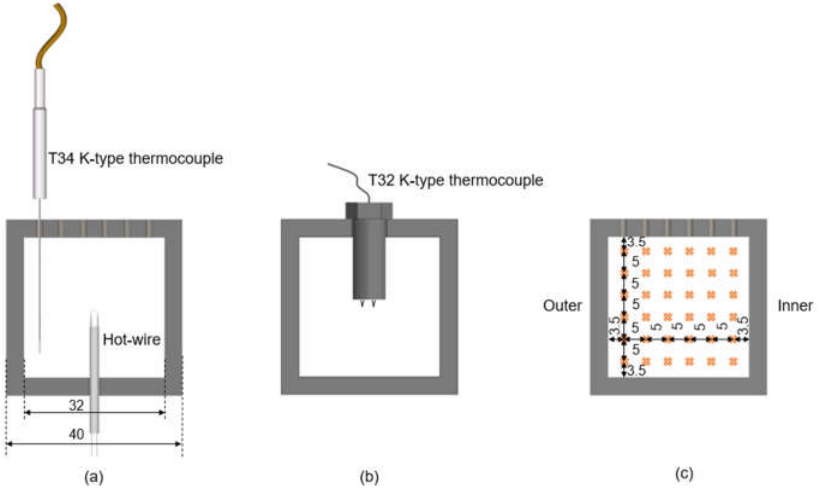
Figure 3. Cross-section of pipes (from upstream view): ( a , b ) measurement methods; ( c ) measurement points [18].